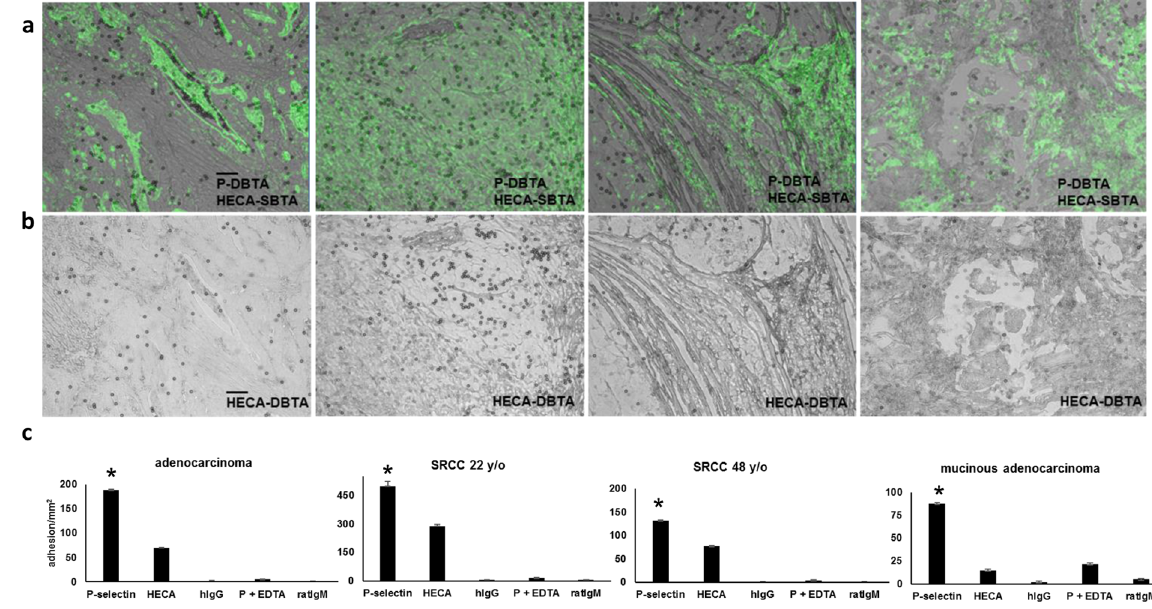
Figure 4. The presence of sLeX/A does not dictate a functional P-selectin ligand. ( a ) SBTA with the HECA- 452 monoclonal antibody (green pseudocolor), which detects both sLeX and sLeA, has been combined with an image showing the adhesion patterns of P-selectin DBTA probes (Fig. 2). HECA-452 SBTA was conducted on serial sections. For the adenocarcinoma and SRCC 22 y/o tissues, but not the SRCC 48 y/o and mucinous adenocarcinoma tissues, there was an agreement between P-selectin DBTA and SBTA with HECA-452 in which the regions of tissue that express sLeX or sLeA mediate adhesion to P-selectin DBTA probes. However, with regard to the SRCC 48 y/o and mucinous adenocarcinoma tissues, not all regions that express sLeX or sLeA, as detected by HECA-452 SBTA, appeared to mediate binding to P-selectin DBTA probes (Supplementary Videos S1, S4, and S7). (b) HECA-452 DBTA probes (microspheres coated with HECA-452) adhered to tissue at 0.50 dyne/cm 2 (Supplementary Videos S9 and S10). (c) The greatest amount of adhesion to the tissue occurred with the P-selectin DBTA probes. Probes were perfused at 250,000 probes/mL and 0.50 dyne/cm 2 . Specificity of interaction was validated using hIgG DBTA probes, 10 mM EDTA, and rIgM DBTA probes as controls. Data shown are mean adhesion ± SD of three technical replicates and are representative of independent experiments conducted on tissue sections from > 3 independent cases of colon cancer. * P < 0.0025, compared to all others intragroup. Scale bar = 100 µ